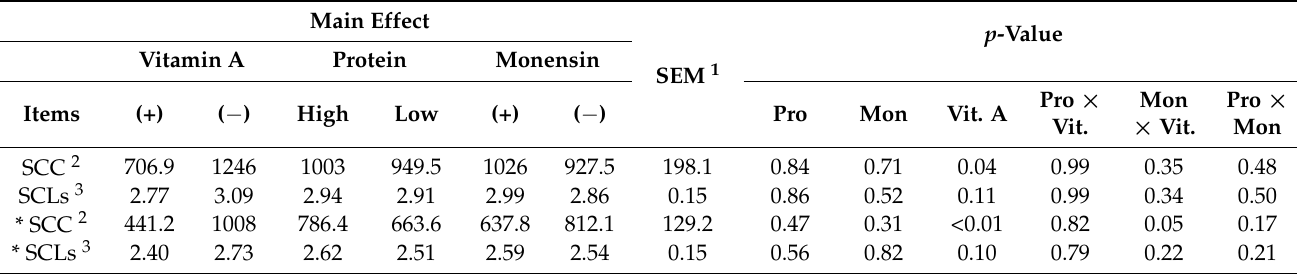
Table 3. Milk somatic cell count and linear somatic cell score during the first 21 days of lactation for multiparous Holstein dairy cows ( n = 80, total) that were fed diets with crude protein levels (10.3%, n = 40 vs. 12.2% dry matter basis, n = 40), and within each crude protein group fed monensin (400 mg/day per head or none) and vitamin A (110 IU/kg body weight or none) during prepartum period (from day − 35 to the day of calving). All cows received a common lactation ration